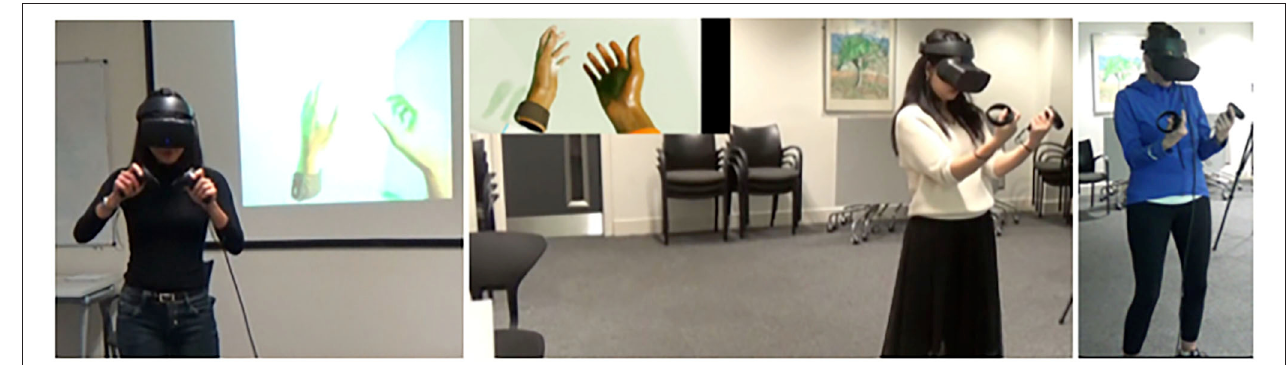
FIGURE 6 | Looking at hands in iVR linked to their own.